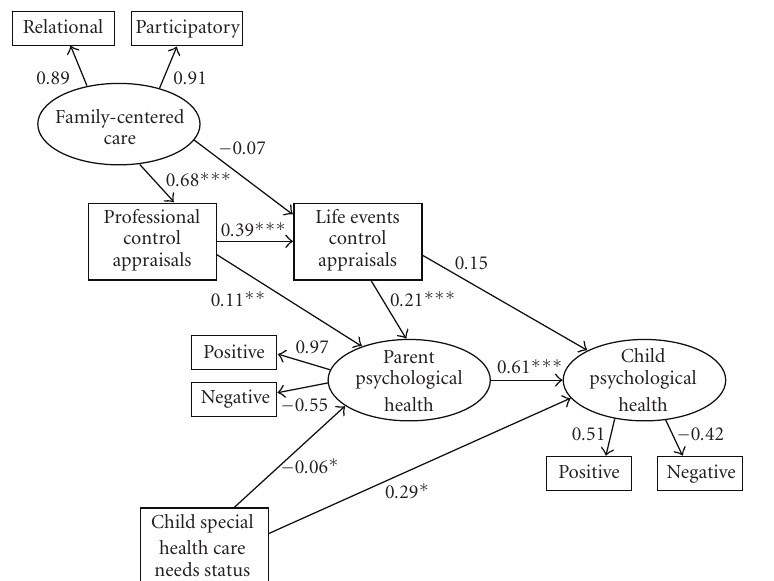
Figure 3: Structural equation modeling results for the respecified model (MODEL II). ∗ P < . 01, ∗∗ P < . 001, ∗∗∗ P < .